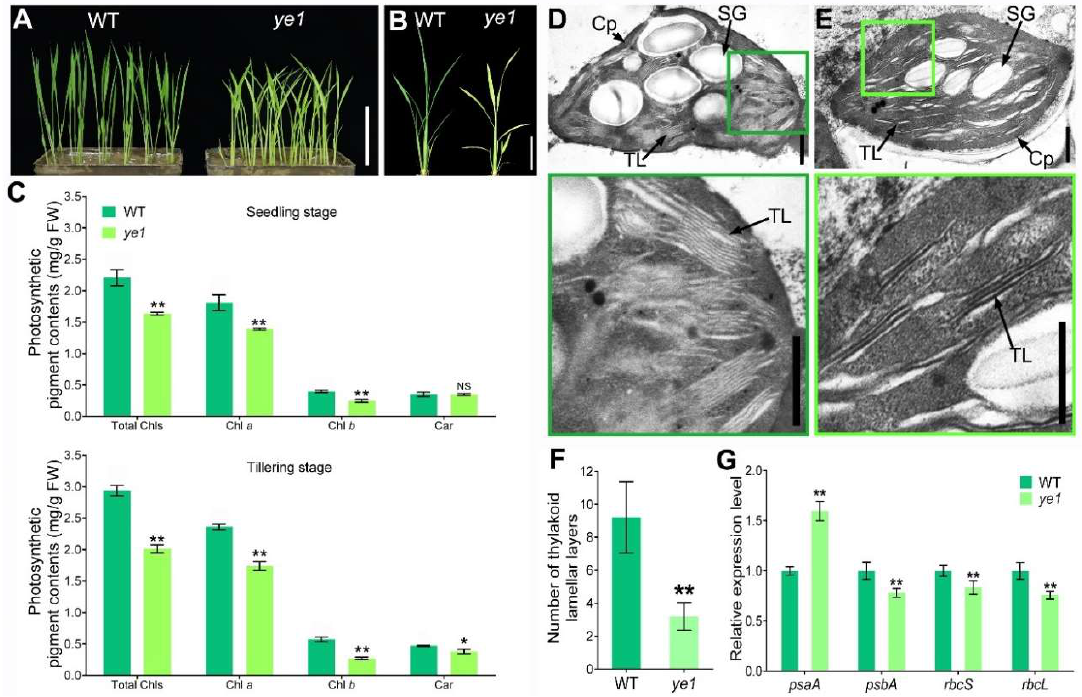
Figure 1. Leaf-color phenotypes of WT and ye1 . ( A ) The appearance of WT and ye1 at the seedling stage. Bar = 10 cm. ( B ) The appearance of WT and ye1 at the early tillering stage. Bar = 10 cm ( C ) Comparisons between the WT and yel in pigment contents at the seedling stage and tillering stage. ( D , E ) TEM analysis of leaves in the WT ( D ) and yel ( E ) seedlings. Cp, chloroplast; SG, starch grain; TL, thylakoid lamellar layer. Bars = 1 µ m. ( F ) Number of thylakoid lamellar layers in the chloroplasts of WT and ye1 seedlings. ( G ) Expression levels of genes related to Photosynthesis in WT and yel plant at the heading stage. Each value is given as means ± standard deviation (SD) or standard errors of mean (SEM) ( n = 3). NS, no significant change. * ( p < 0.05) and ** ( p < 0.01) indicate significant differences between WT and ye1 (Student’s t -test).